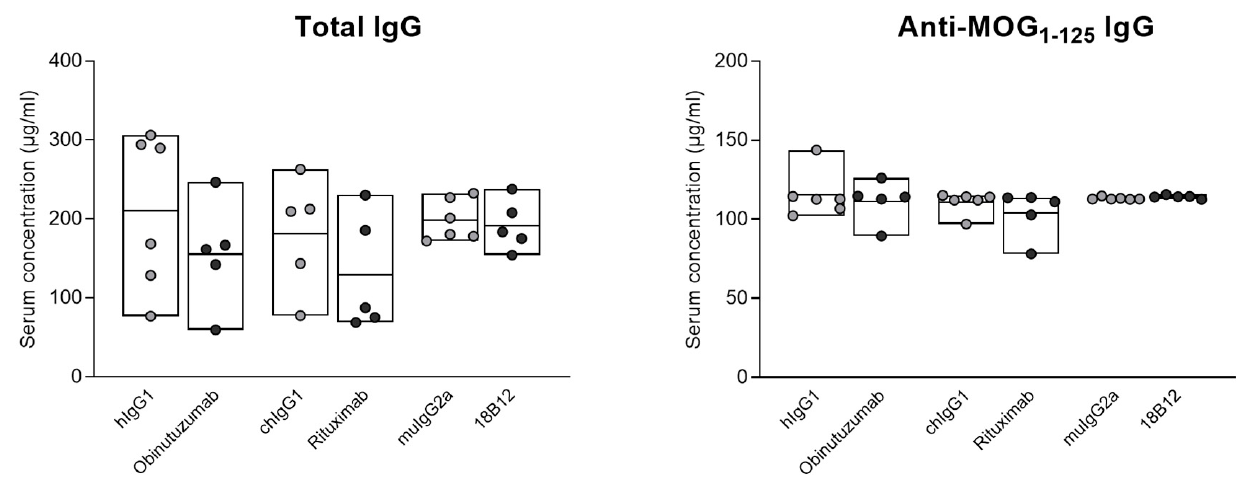
Figure 2. Serum levels of total and anti-MOG 1–125 IgG in hCD20xhIgR3 and WT B6 mice. Mice were each injected three times with 5 mg/kg anti-CD20 mAbs or the corresponding isotype controls. Serum IgG levels were determined by ELISA in 5–6 mice per group, 7 days after the last injection. Each circle represents the mean value for an individual mouse. The bars indicate the group mean value as well as minimum and maximum values. Statistical significance was evaluated by unpaired t -test. There was no statistically significant difference between any of the groups. Flow cytometric analysis of the spleen was performed to investigate the depleting capacity of the different anti-CD20 mAbs. Splenic B cells were isolated from 5 to 6 mice per group, 7 days after the end of treatment with anti-CD20 mAbs or corresponding isotype con- trols. As shown in Figure 3, obinutuzumab-treated mice displayed decreased numbers of naïve (CD19 + /IgM − / IgD + ) (Figure 3B), marginal zone (CD19 + /CD93 − /CD21 hi /CD1d hi ) (Figure 3C), follicular (CD19 + /CD93 − /CD21 int /CD1d lo ) (Figure 3D), and isotype-switched (CD19 + /IgG + ) B cells (Figure 3G). Rituximab treatment mainly depleted isotype-switched B cells (Figure 3G). 18B12, which was used as mouse anti-CD20 mAb in WT B6 mice, was highly potent and depleted approximately 90% of all B cell subsets (Figure 3A; p ≤ 0.001 vs. isotype control (Welch’s t -test)) except for memory B cells and marginal zone B cells (Figure 3B–D; naïve B cells: p ≤ 0.01 vs. isotype control (Mann–Whitney U test); fol- licular B cells: p ≤ 0.01 vs. isotype control (Welch’s t -test)). Interestingly, although memory (CD19 + /CD80 + /CD73 + ) B cells express CD20, they were spared by anti-CD20 mAb-mediated depletion in all three treatment groups (Figure 3F). The relative depletion compared to the isotype control is provided in Figure 3I for each